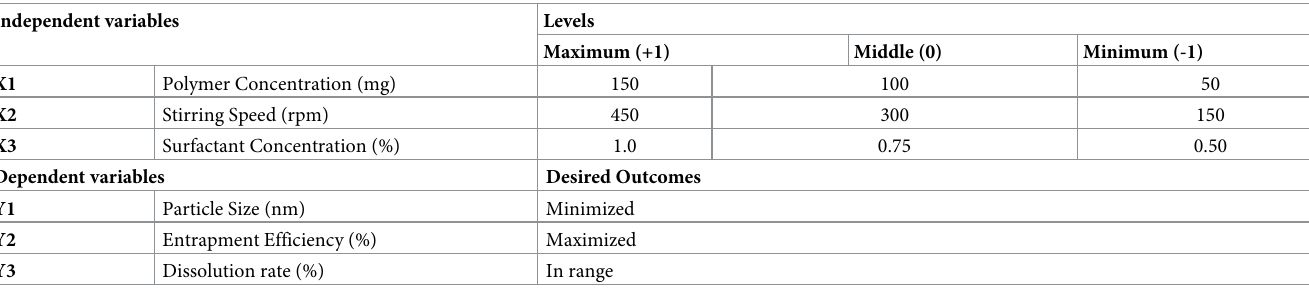
Table 1. Levels of independent and dependent variables in design of experiment. Independent